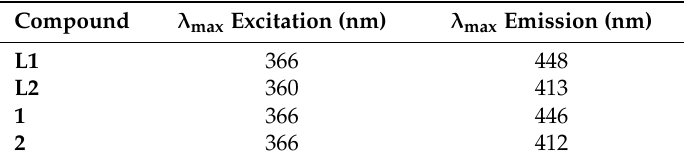
Figure 10. Deconvoluted excitation (black) and emission (red) spectra for compounds L1 and L2 ( top ) and compounds 1 and 2 ( bottom ). Table 2. Excitation and emission data for compounds L1 , L2 , 1 , and 2 .